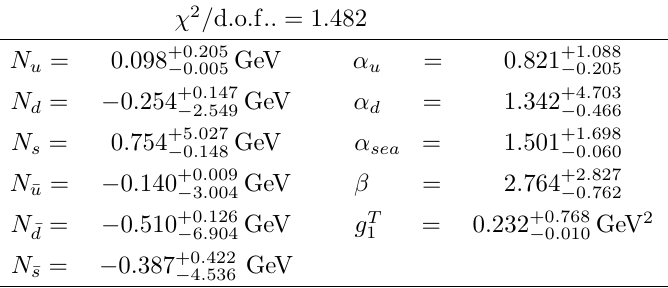
Table 6 . Fit parameters for fit 2b in table 1. The presented values is the parameter value of the fit with no Gaussian noise. The uncertainties for the replicas are generated from the parameter values which lie on the boundary of 68% confidence.